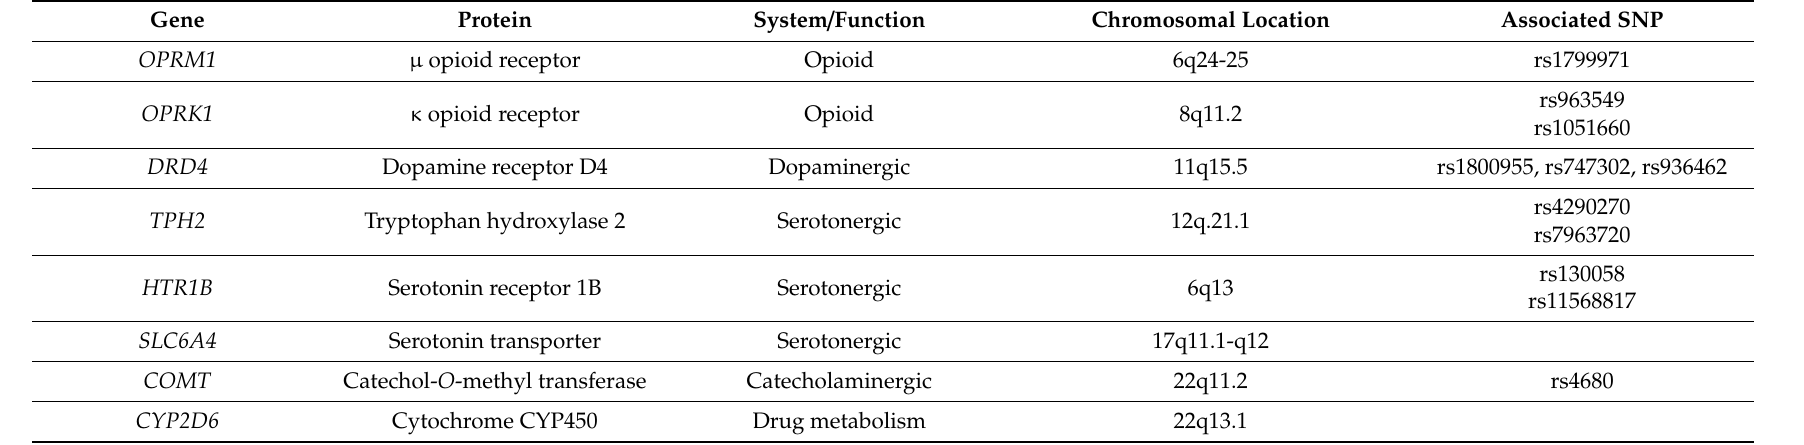
Table 1. Characteristics of genes related to heroin / opiate dependence and